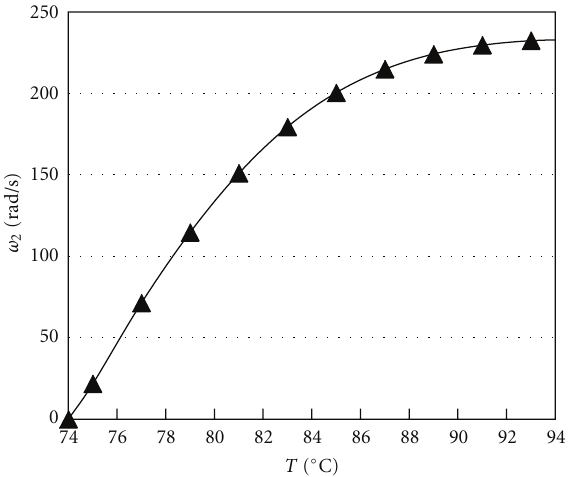
Figure 7: The output angular velocity versus